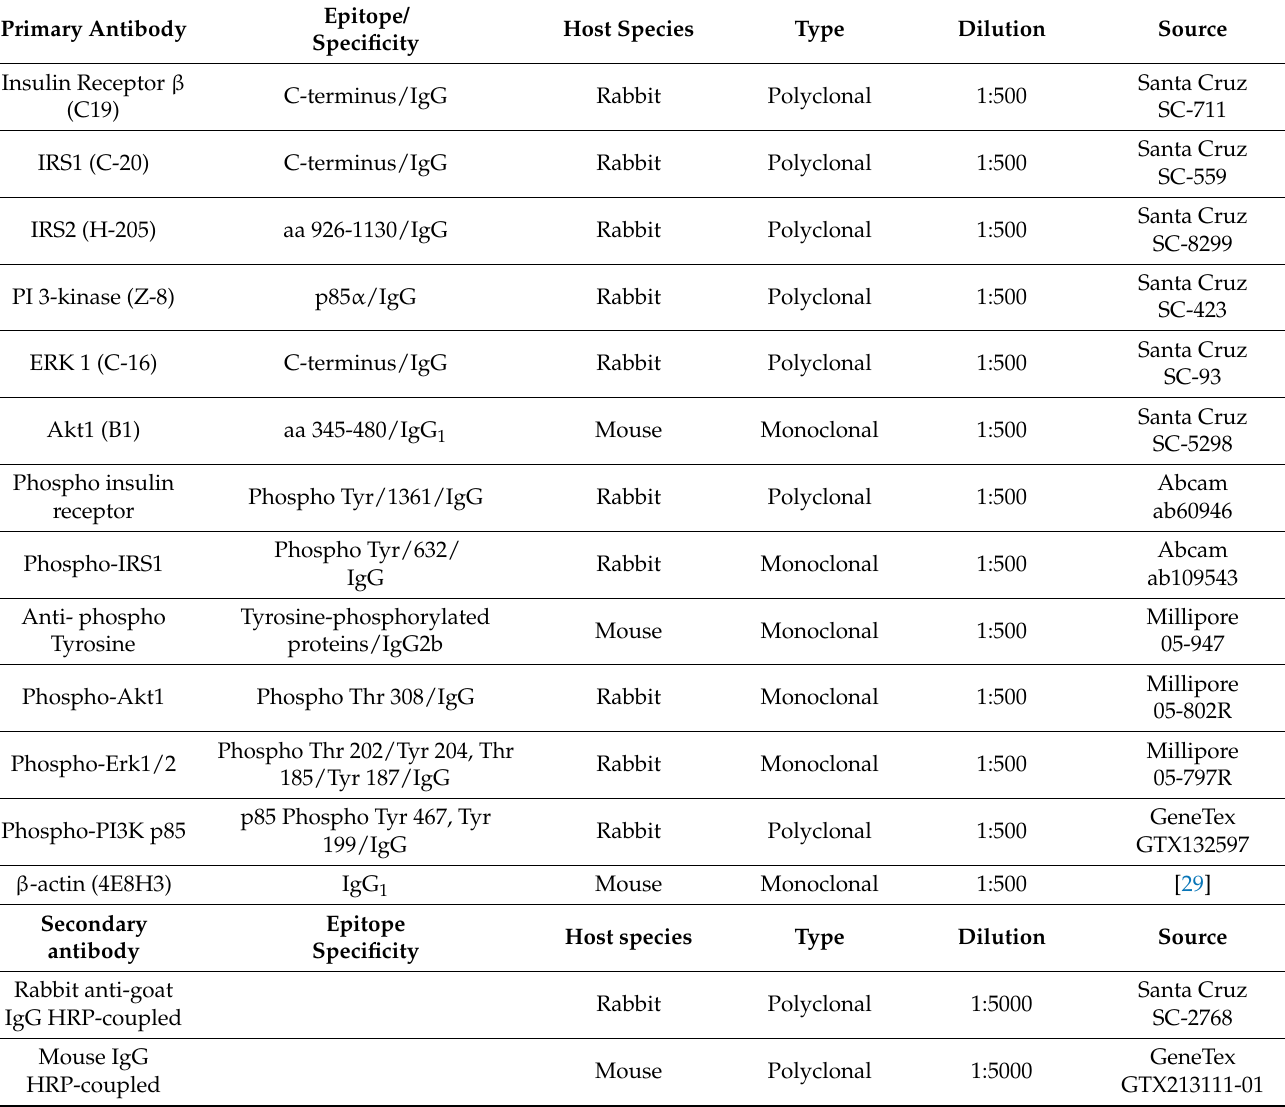
Table 2. List of primary and secondary